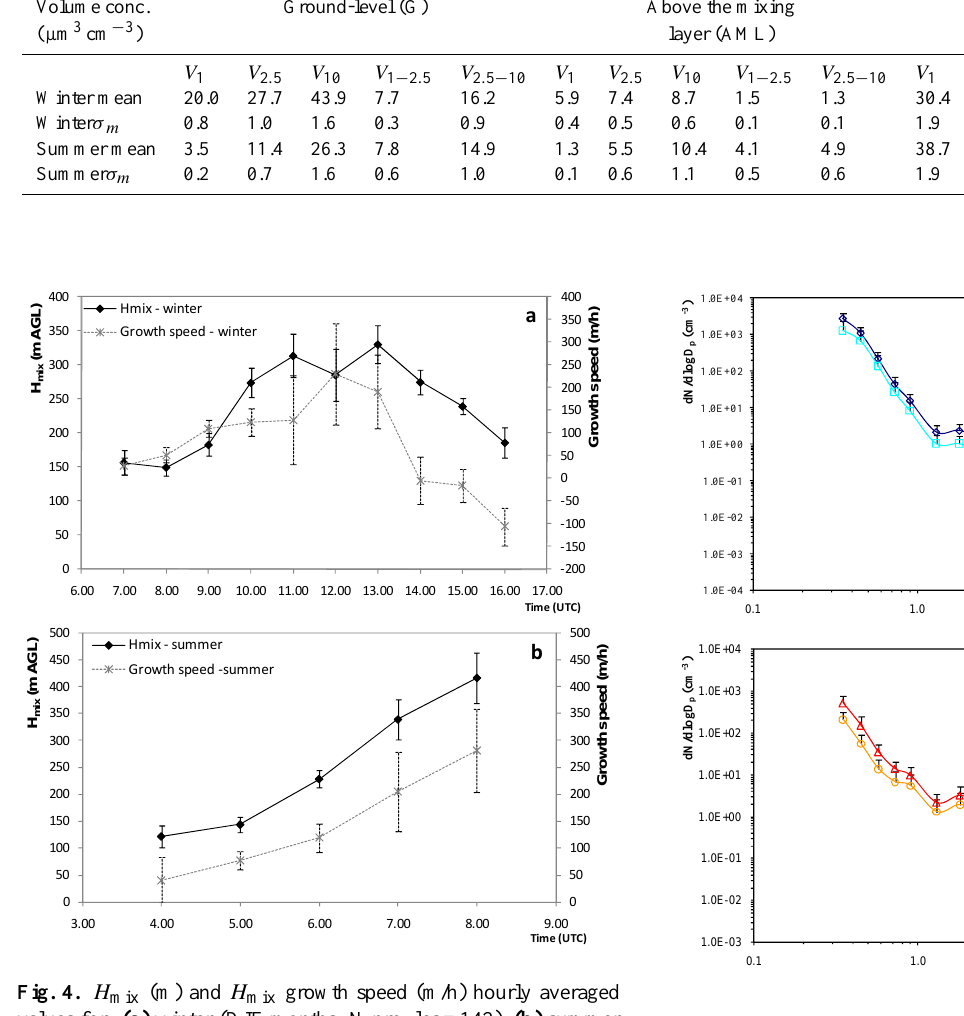
mixing layer to that measured at ground